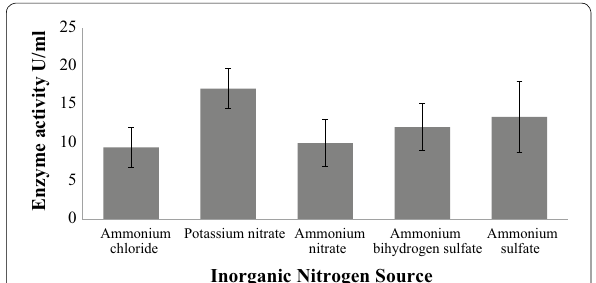
Fig. 5 Effect of inorganic nitrogen source on keratinase production by Arthrobacter sp. NFH5. The fermentation was carried out at 37 °C with pH 7.5 at 150 rpm for 72 h. Data represent the means ard deviations for triplicate